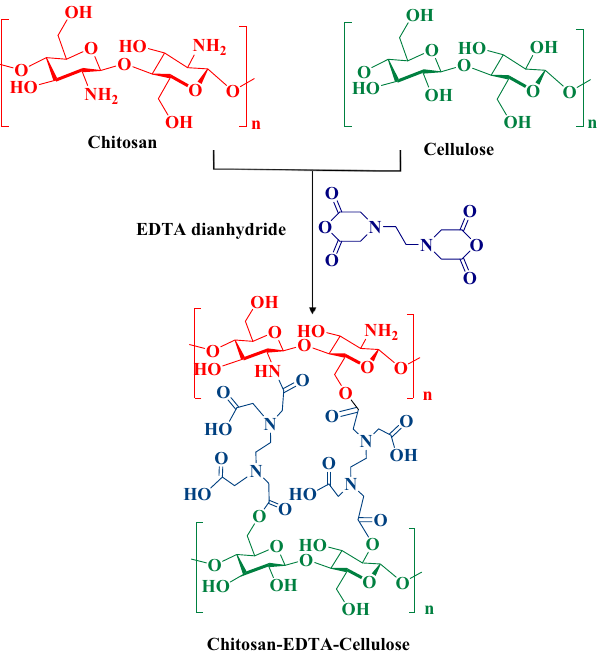
Figure 1. Schematic preparation of the multifunctional heterogeneous Cs-EDTA-Cell network ( 1